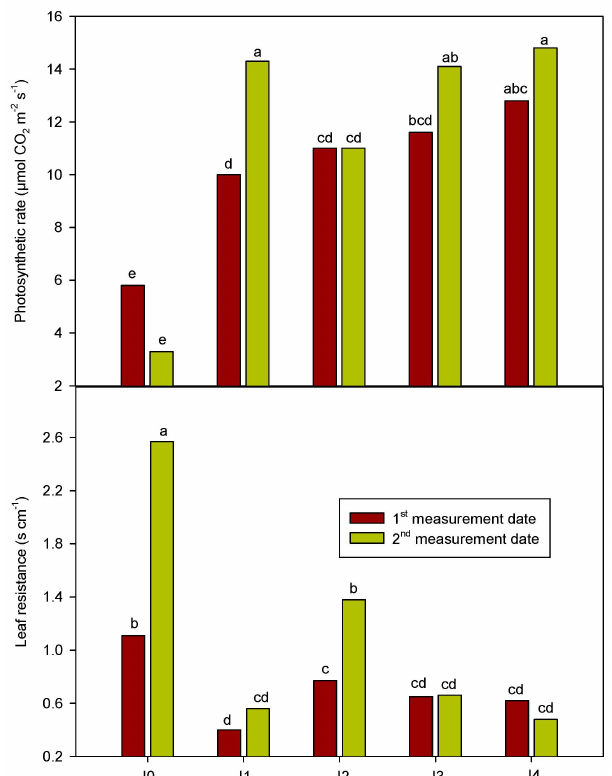
Figure 3. Photosynthetic rate and leaf resistance as affected by “irrigation regime × measurement dates” interaction in Season I. Different letters for each parameter indicate significant differences at p ≤